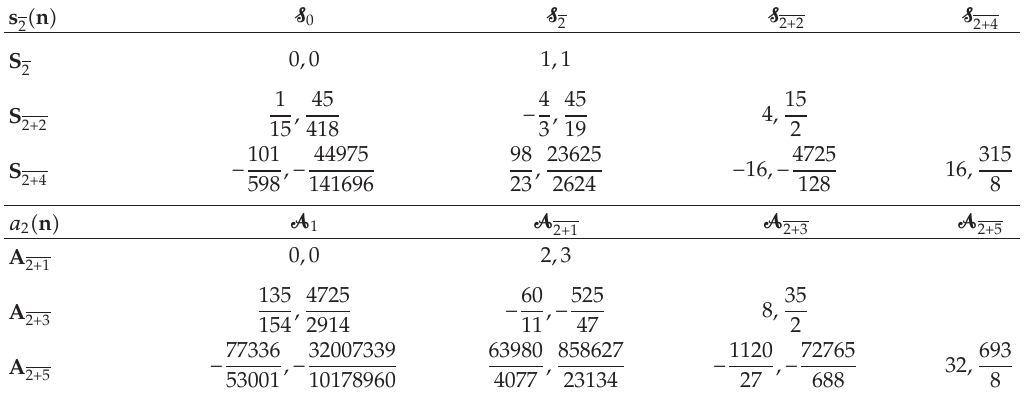
Table 3: Coe ffi cients of the lower order fabric tensors of the second kind using symmetric characterization for second-order tensor-valued ODFs (cid:3) 2D and 3D (cid:4)